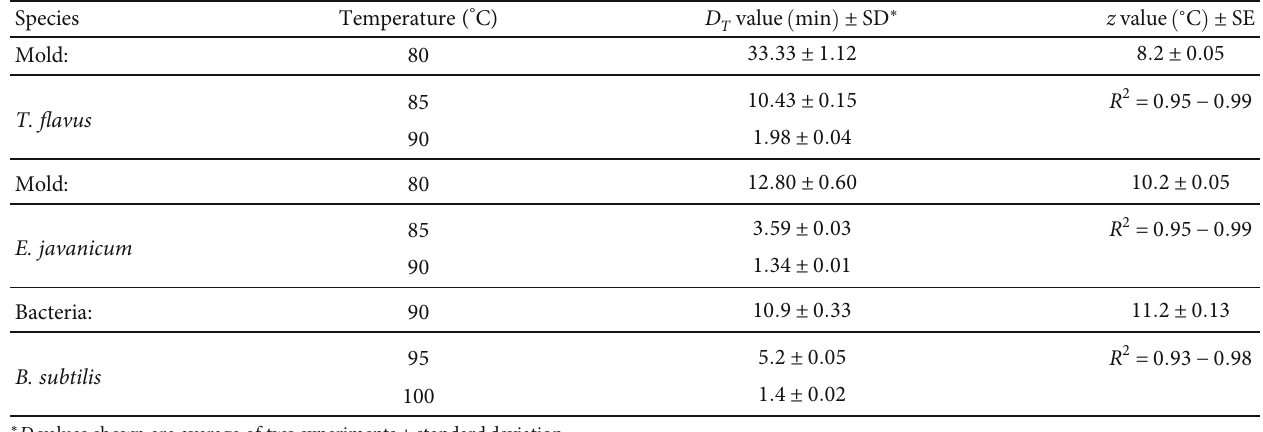
Table 3: Heat resistance of spores of Talaromyces fl avus and Eupenicillium javanicum in guava juice (pH 3.5) treated with 0.015% sodium benzoate.